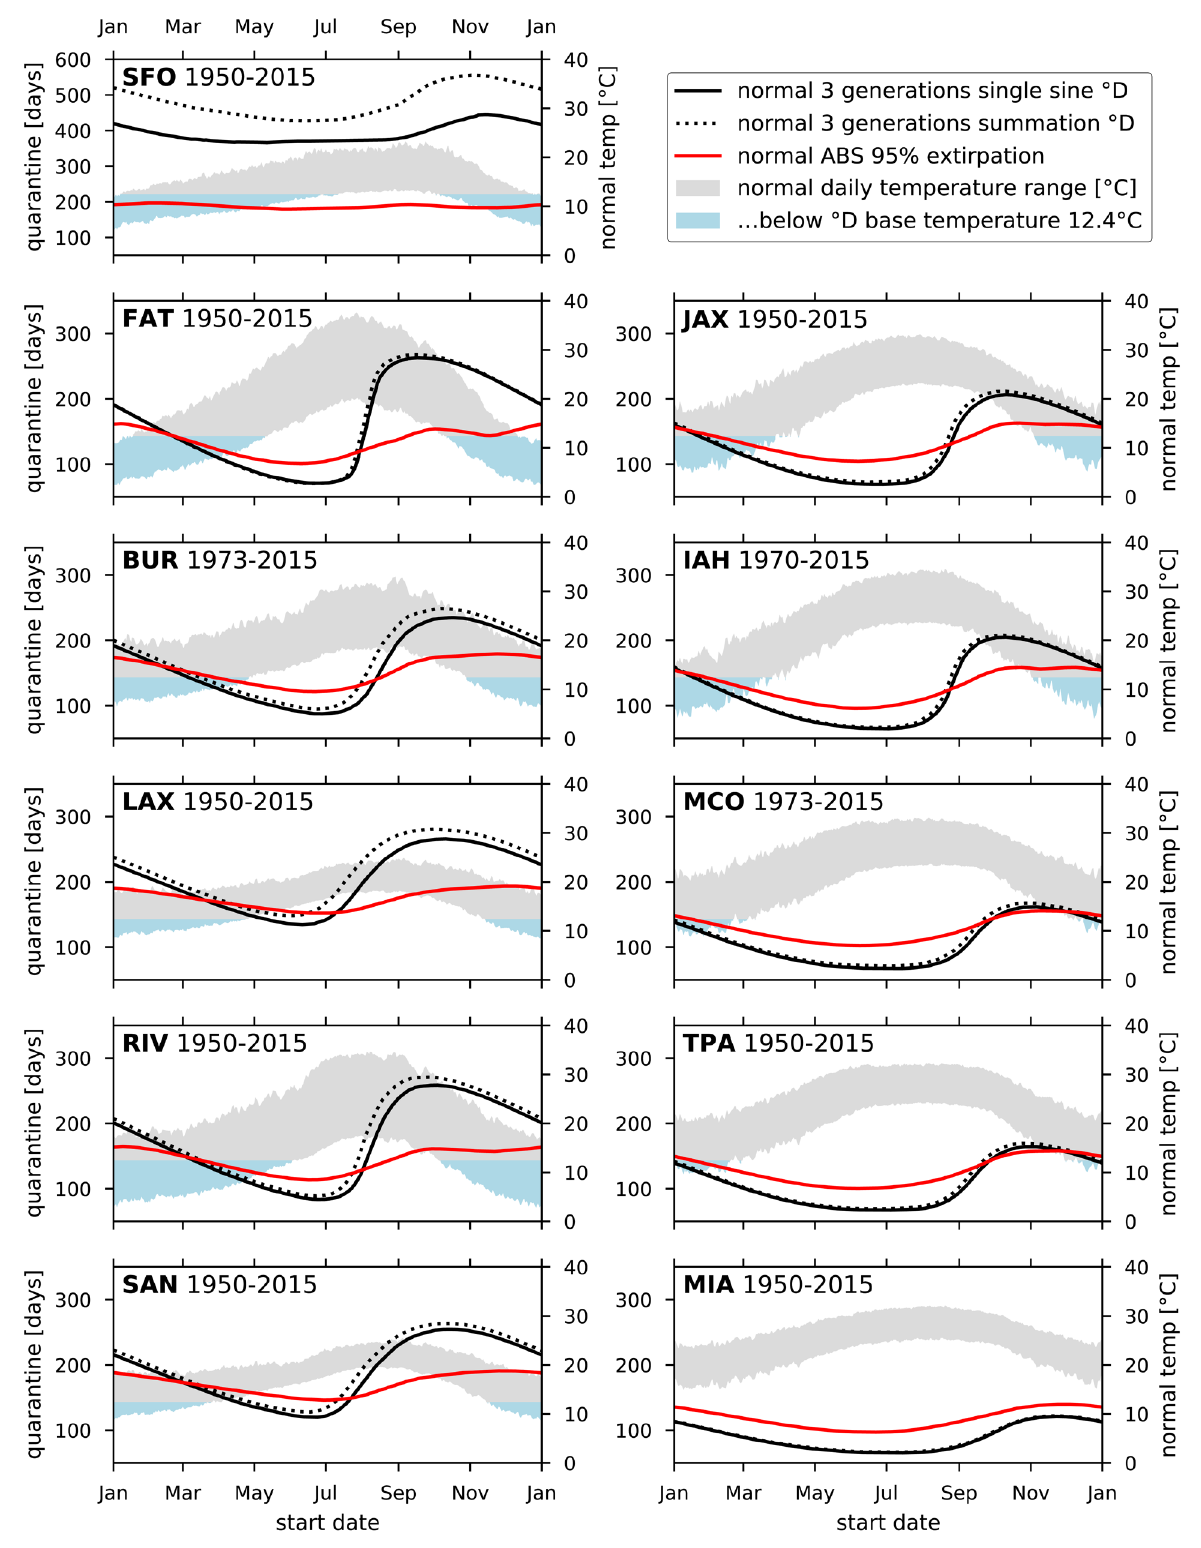
Figure 2. Summary of normal predicted quarantine length for each site and start date (last fly detection). Year range of input temperature data used is inclusive. All panels have identical limits except SFO